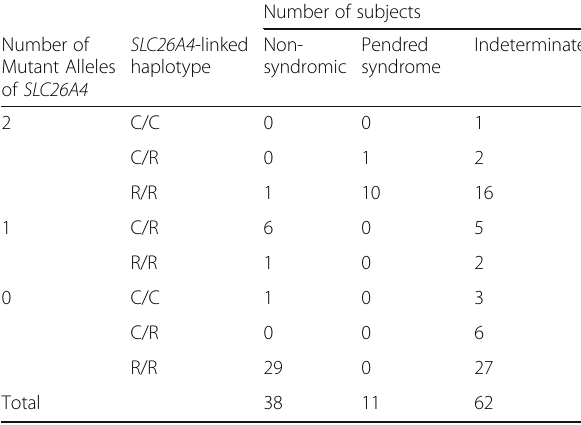
Table 2 Thyroid phenotypes of study subjects Number of subjects